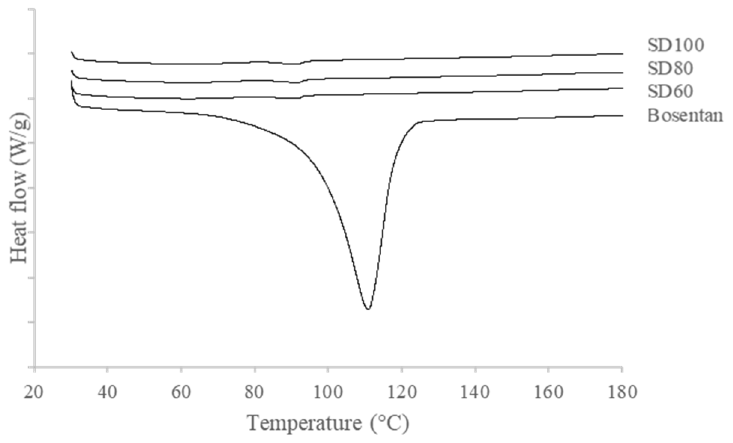
Figure 3. DSC thermograms of spray-dried bosentan microparticles and raw bosentan.